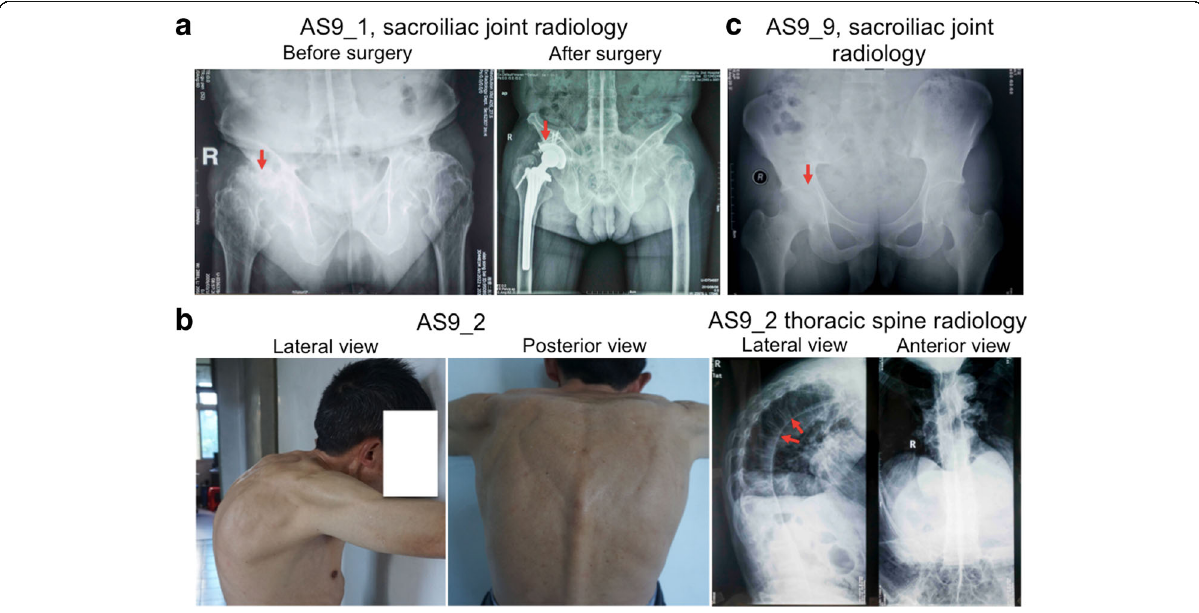
Fig. 1 Medical images of AS9 patients. a X-ray pictures of the sacroiliac joints of the proband, AS9_1, before (left) and after (right) joint replacement surgery. Arrows indicate erosion of the right joint before the surgery (left) and the artificial joint after the surgery (right). b Medical images of patient AS9_2, showing the deformation of the thoracic spine due to ankylosis (left). X-ray pictures showing the “ bamboo ” -like spines of AS9_2 (right). Arrows point to the sites of fused vertebrae. c Sacroiliitis of patient AS9_9 detected by X-ray